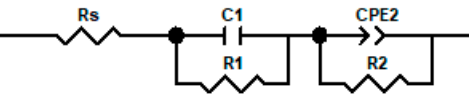
Figure 13. Equivalent electric circuit.